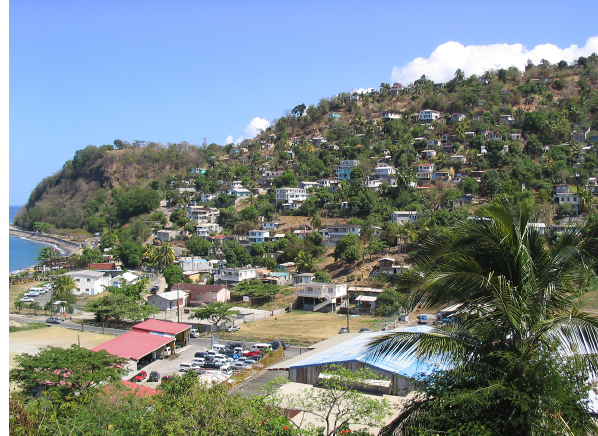
Figure 1. Typical informal housing on a landslide-prone slope in the eastern Caribbean (photograph by Holcombe,